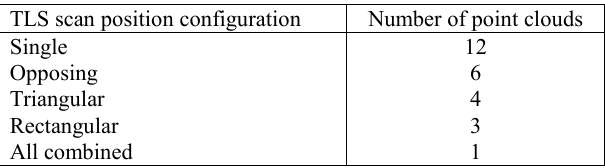
Table 1. Examined terrestrial laser scan position configurations and number of respective point clouds